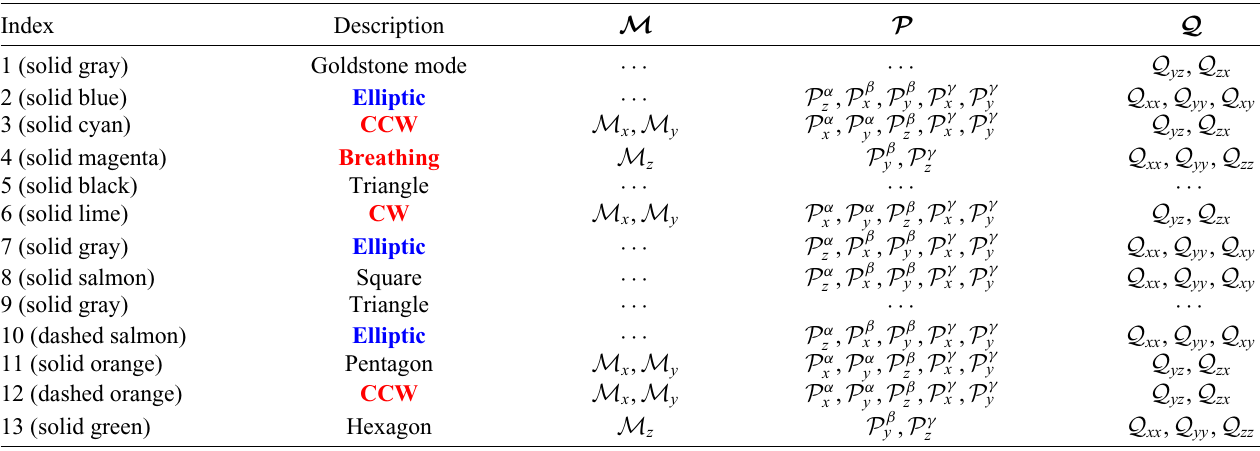
TABLE I. Dynamical magnetic dipole moment, electric dipole moment, and magnetic quadrupole moment of low-energy magnon modes of SkXs in Cu 2 OSeO 3 . The absence of a finite component is denoted by an ellipsis. For relative magnitudes, compare with Fig. 3 in the main text and Fig. 10. If the corresponding single-skyrmion bound states are magnetically (electrically) active, they are highlighted in bold red (blue). In the “Index” column, the colors in brackets coincide with the colors chosen in Fig. 7(b). We denote P α , P β , and P γ as electric polarizations with ˆ z (cid:9) [001], [110], and [111], respectively. For all cases, the x axis is taken along